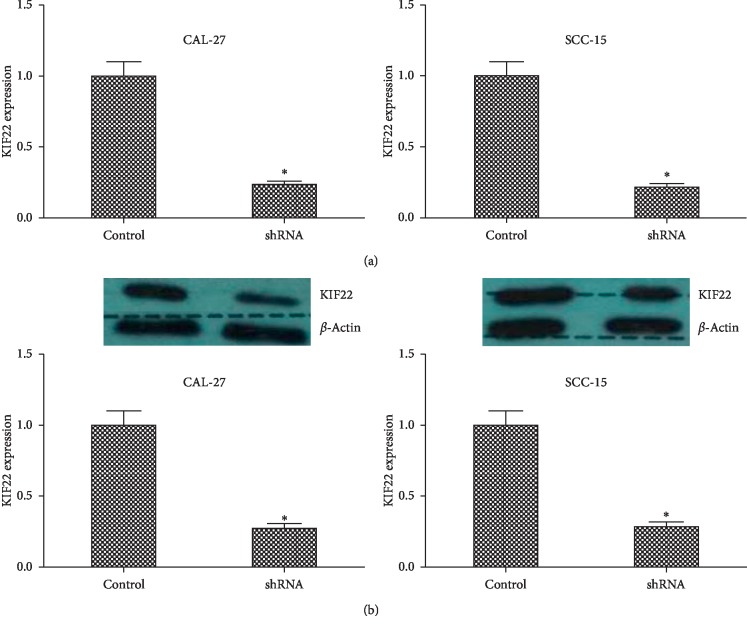
Stable clone of suppression of KIF22 in CAL-27 cells and SCC-15 cells with shRNA. (a) KIF22 mRNA expression level in CAL-27cells and SCC-15 cells transfected with shRNA to knockdown KIF22, respectively. (b) The protein expression level of KIF22 in CAL-27 cells and SCC-15 cells was detected using western blot and quantified by ImageJ ∗P < 0.05.